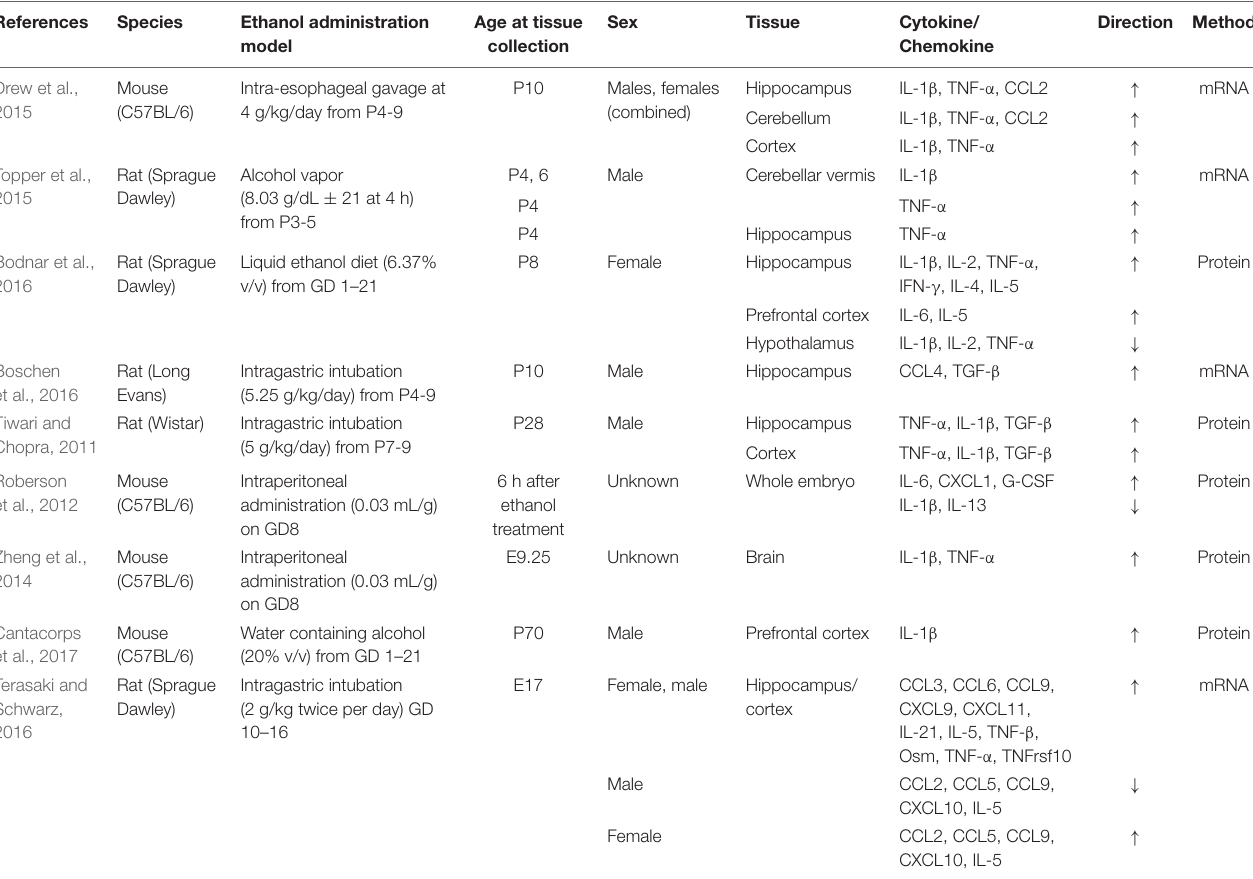
TABLE 1 | Studies showing the impact of prenatal/early postnatal (third trimester equivalent) alcohol exposure on central cytokine